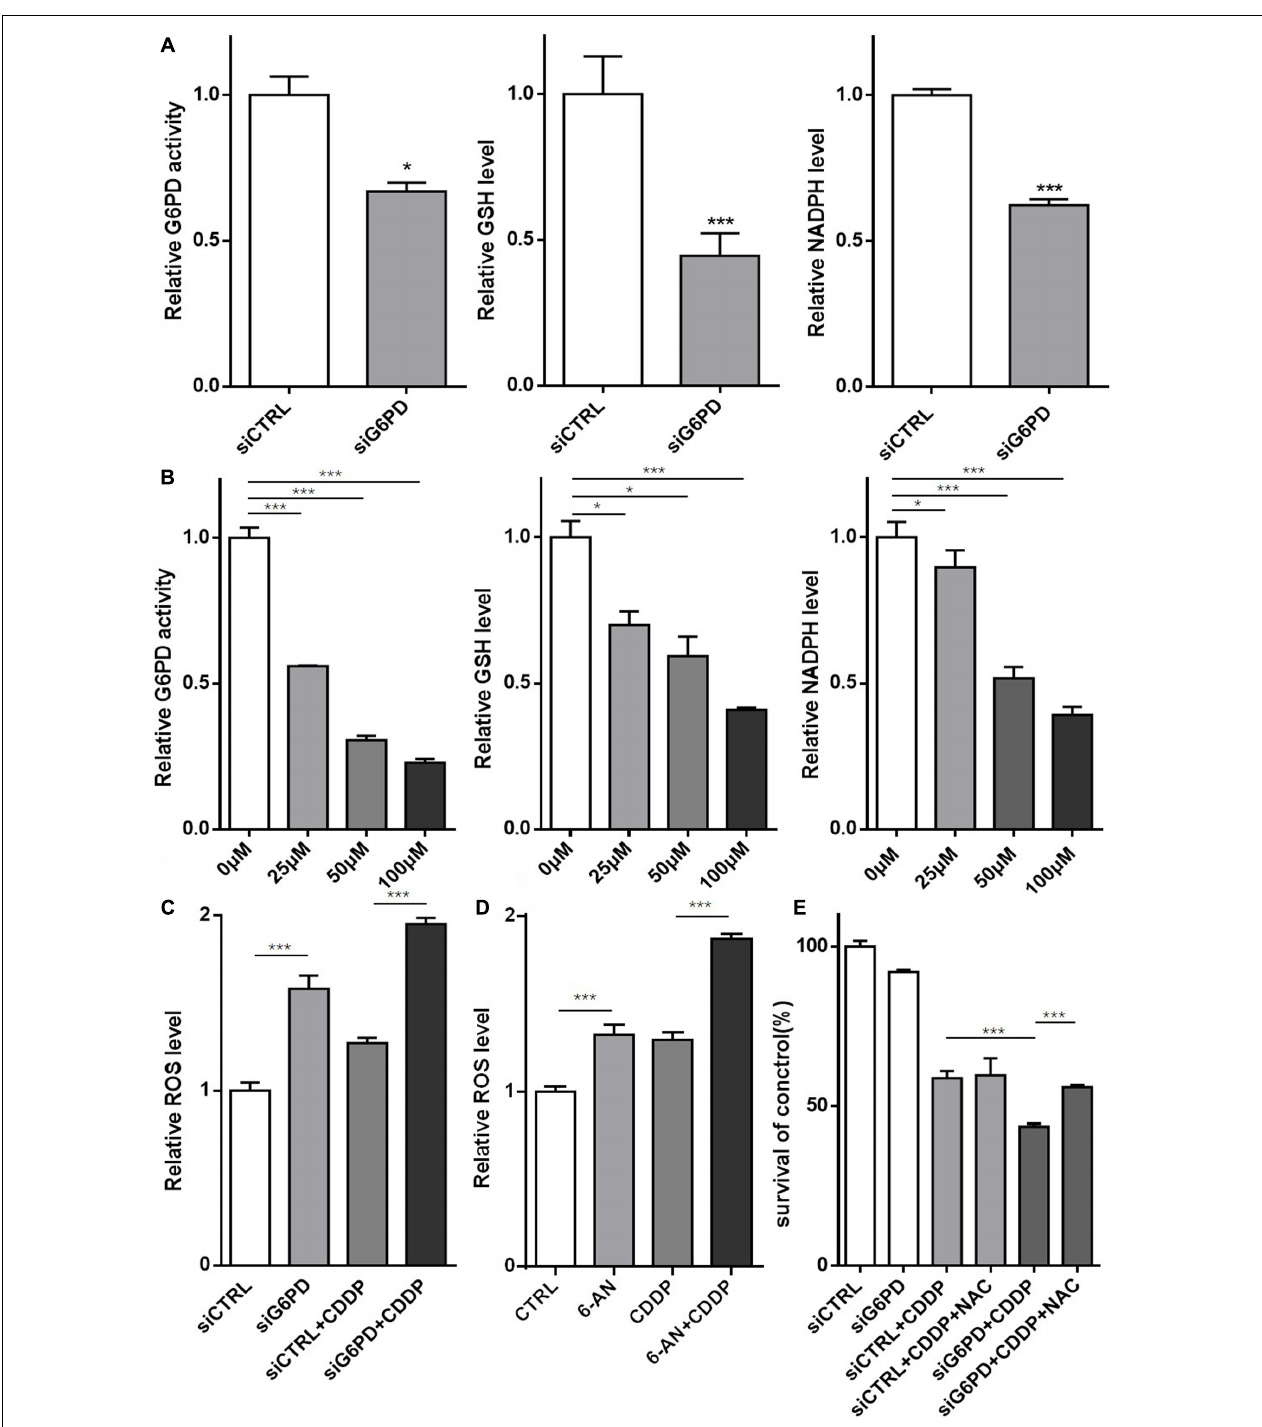
FIGURE 6 | Inhibition of G6PD sensitized A549/DDP cells to cisplatin through inducing oxidative stress. (A) The relative G6PD enzymatic activity and the GSH and NADPH levels were assessed in A549/DDP cells transfected with siRNA. (B) The relative G6PD enzymatic activity and GSH and NADPH levels were assessed in A549/DDP cells treated with various concentrations of 6-AN. (C) A549/DDP cells transfected with siRNA were treated with or without cisplatin for 48 h, and the ROS level was assessed. (D) A549/DDP cells were treated with cisplatin and 6-AN separately or in combination for 48 h, and the ROS level was assessed. (E) A549/DDP cells transfected with siRNA were treated with cisplatin and NAC separately or in combination for 48 h, and the cell viability was assessed by MTT assay. Data are presented as the means ± SD ( n = 3), and the significant differences are indicated as ∗ P < 0.05, ∗∗ P < 0.01, and ∗∗∗ P < 0.001.